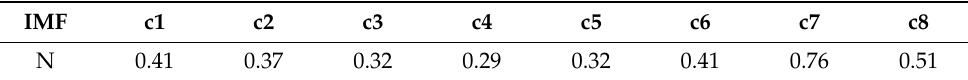
Table 2. CCs between each component location in site P242 based on the position time series and its corresponding IMFs.